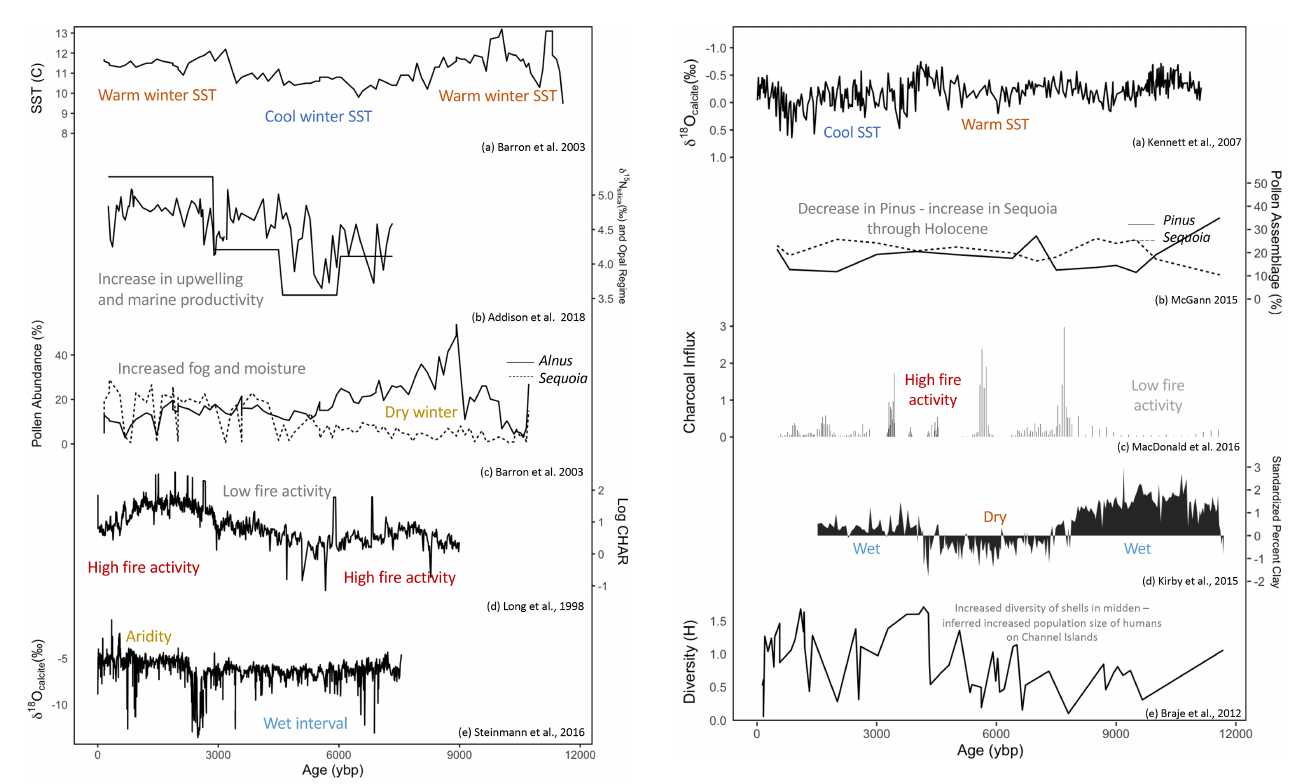
Figure 4. Representative datasets from the Pacific Northwest. Pan- els from top to bottom alkenone sea surface temperature from core ODP 1019 ( a , Barron et al., 2003). Bulk sediment δ 15 N and opal regime index from core TN062-O550 ( b , Addison et al., 2018). Rel- ative abundance of pollen: solid line is Alnus (alder) and dashed line is Sequoia (coastal redwood) from core ODP1019 ( c , Barron et al., 2003). Log charcoal accumulation rate at Little Lake ( d , Long et al., 1998). Lake sediment bulk calcite δ 18O from Cleland Lake, Wash- ington ( e , Steinman et al., 2016).